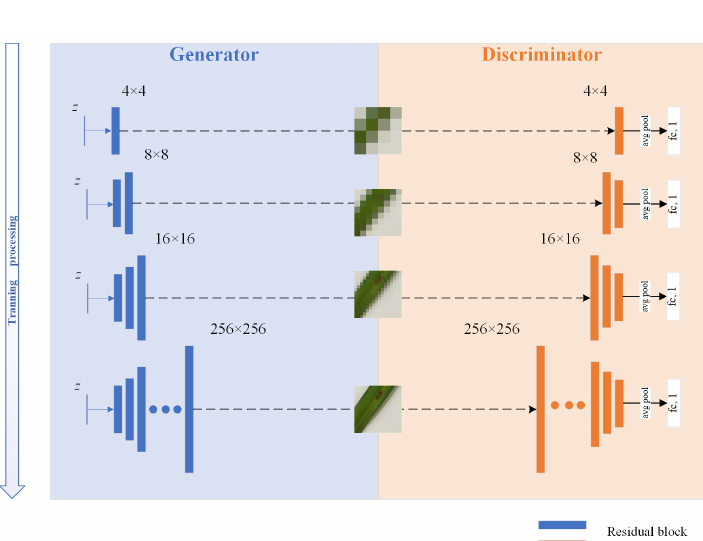
Figure 6. PWGAN-GP